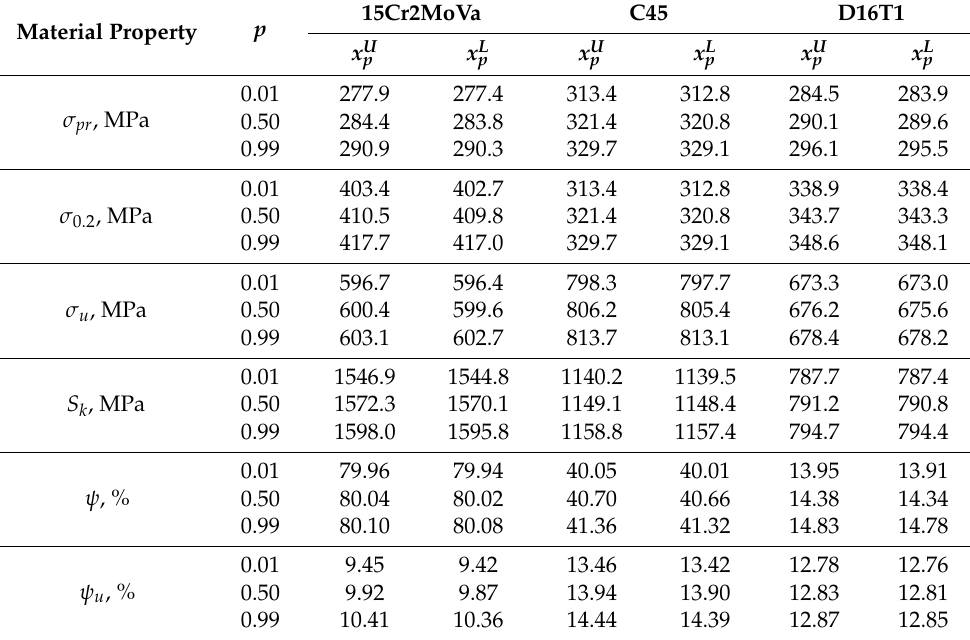
Table 4. The range of confidence intervals of mechanical properties.